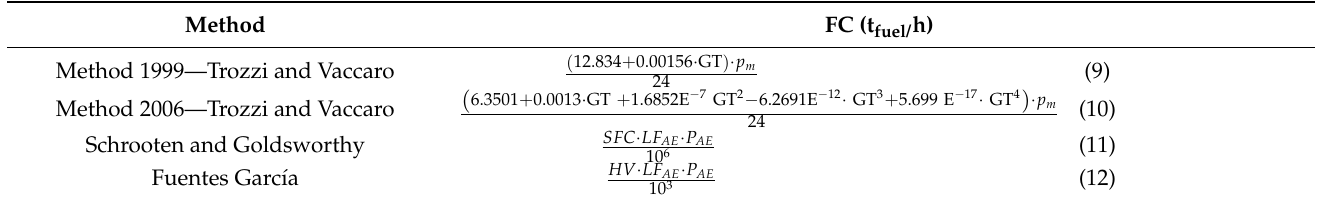
Table 8. Calculation methods for fuel consumption (FC) of Ro–Ro ships as a function of GT or P AE . Method FC (t fuel/